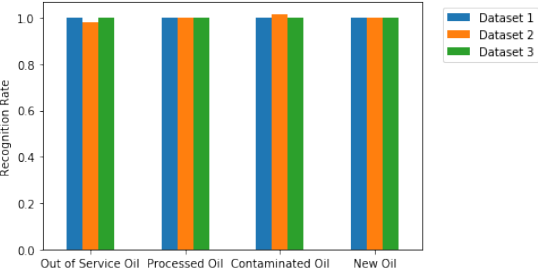
Figure 13. Recognition Rate per Oil and Dataset.